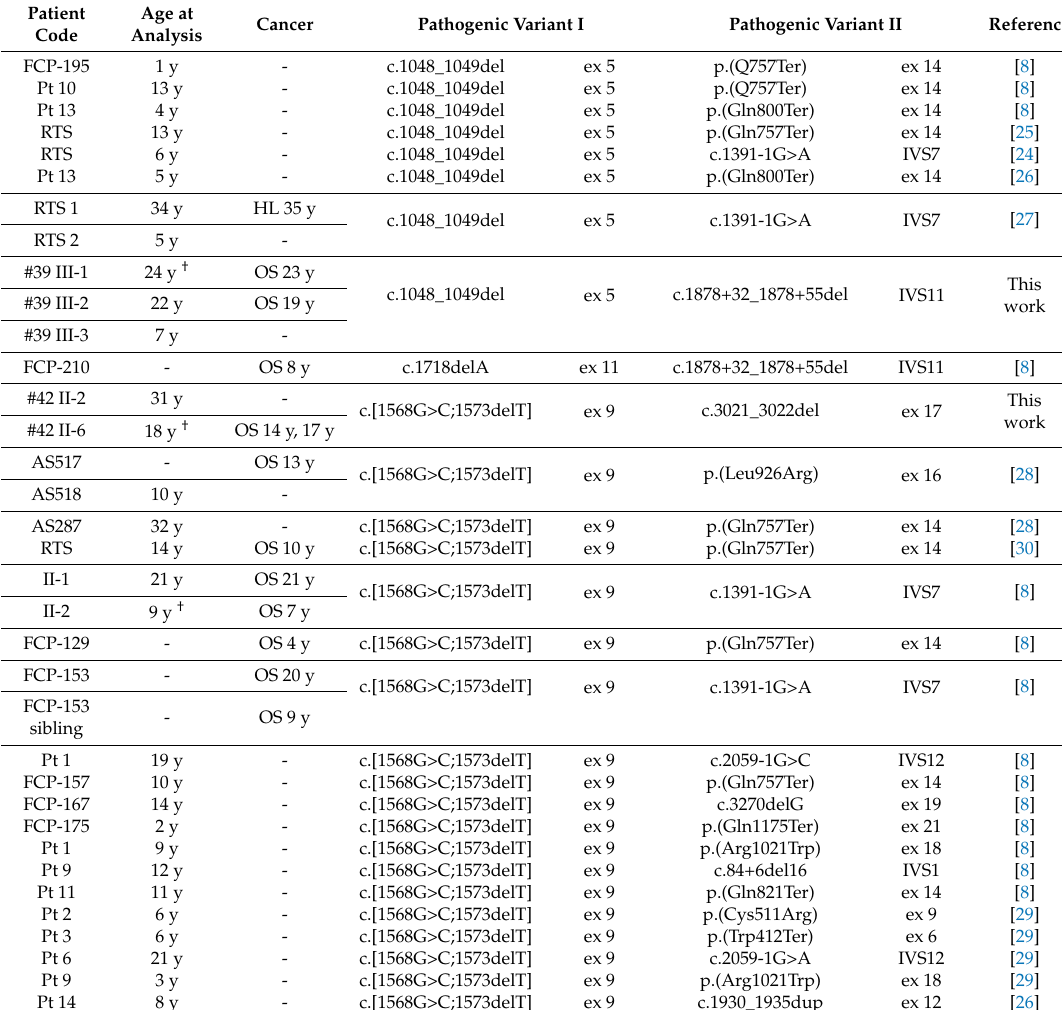
Table 2. Survey of tumor incidence in literature RTS patients carrying the same pathogenic variants of our patients with osteosarcoma outcome (families B and